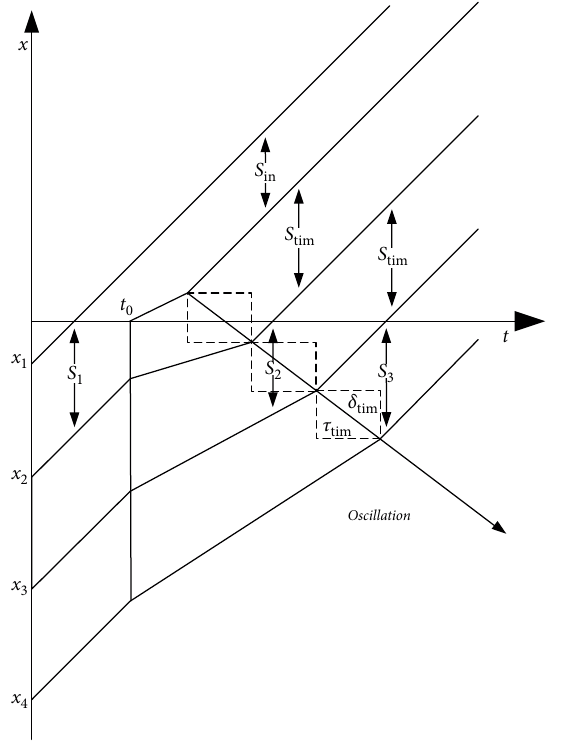
Figure 5: Schematic diagram of the real traffic ESN.